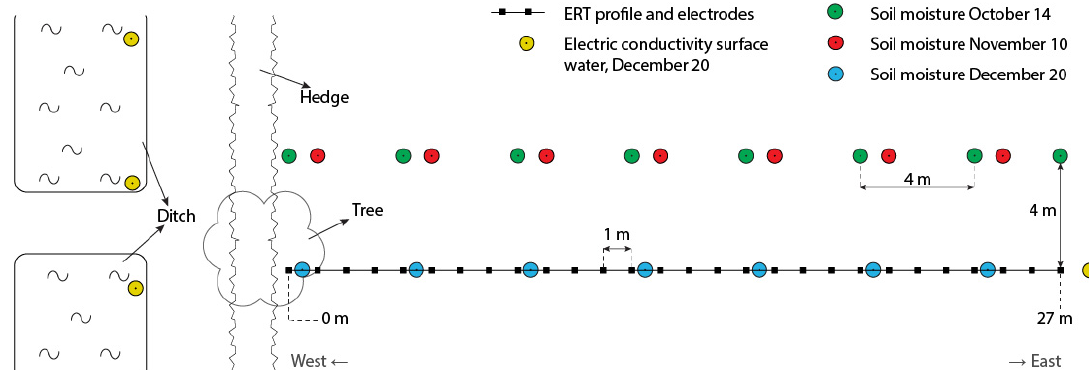
Figure 1. Plan view of the electric resistivity tomography (ERT) sensor 2016 set-up, including ERT electrodes, soil moisture measurement points, and surrounding features. The ERT transect of 27 m length is indicated by a black line and the small black squares indicate the positions of the electrodes with 1 m spacing. The colored circles illustrate the locations of the gravimetric sampling. October (green) and November (red) measurements were taken parallel to the ERT transect at a distance of 4 m away from the ERT transect to avoid disturbance to the ERT experiment. The December (blue) measurements were taken along the ERT transect in between the electrodes at the end of the experiment. Yellow circles represent the locations of Electric Conductivity (EC) measurements in surface or groundwater to determine possible effects on the ERT measurements.